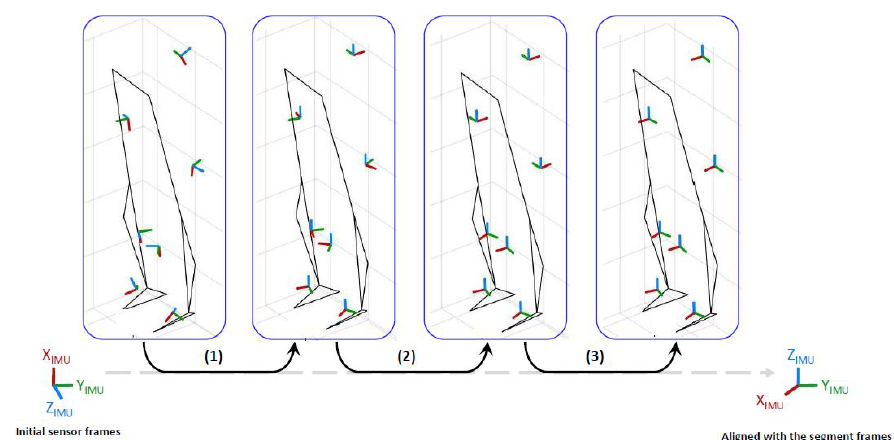
Figure 4. Illustrations of the S2S steps from the initial sensor frames to the segment frames in the standing pose. ( 1 ) Z alignment (blue axis) thanks to the gravity measured by the accelerometers during standing posture, ( 2 ) Y alignment (green axis) with the principal axis of movement measured by the gyroscopes during gait, ( 3 ) Correction of the Y axis direction thanks to the acceleration measured during the sitting posture leg extended.